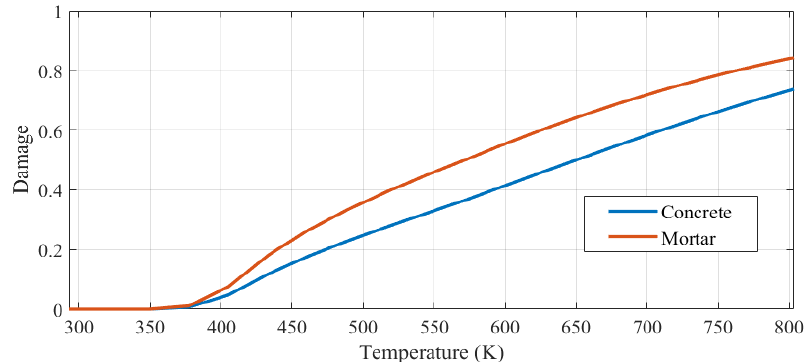
Figure 13. Relation between damage and temperature.